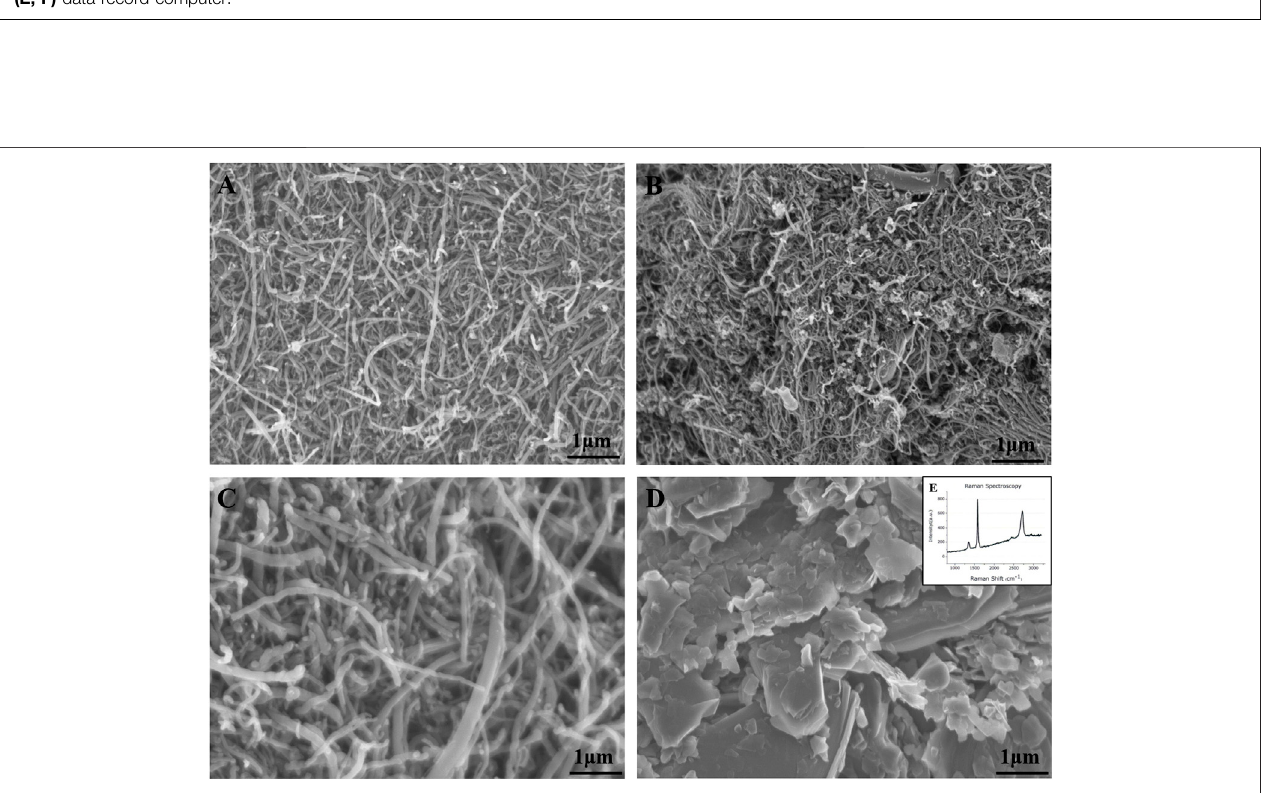
FIGURE 3 | SEM images of (A) CNT (SSA165), (B) CNT (SSA500), (C) CNT (SSA60), (D) GNP.